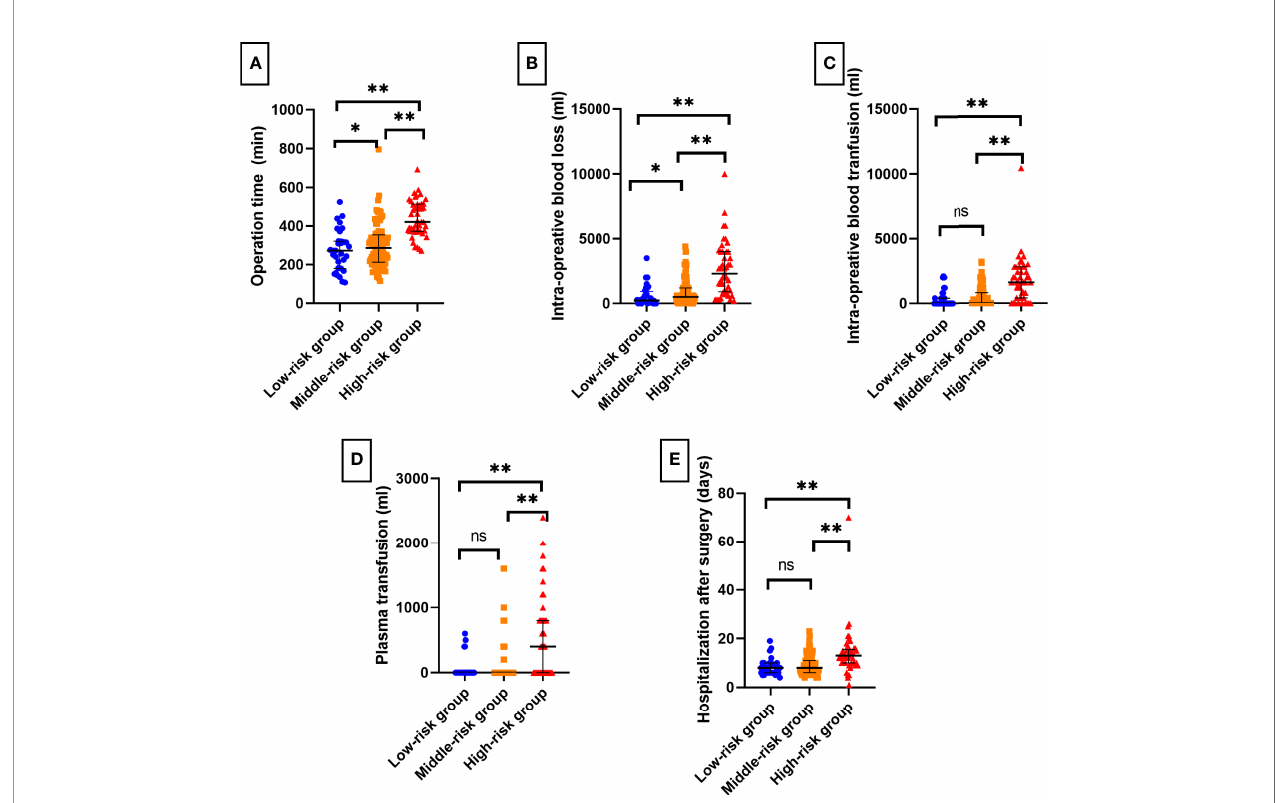
FIGURE 3 | Bar charts of surgical complexity indicators and short-term postoperative recovery among T.H.R.O.B.V.S. risk strati fi cations. The grading system had a good effect on predicting (A) operation time, (B) intraoperative blood loss, (C) blood transfusion, (D) plasma transfusion, and (E) postoperative hospital stays. ns, no signi fi cant difference; *P < 0.05; **P < 0.01.